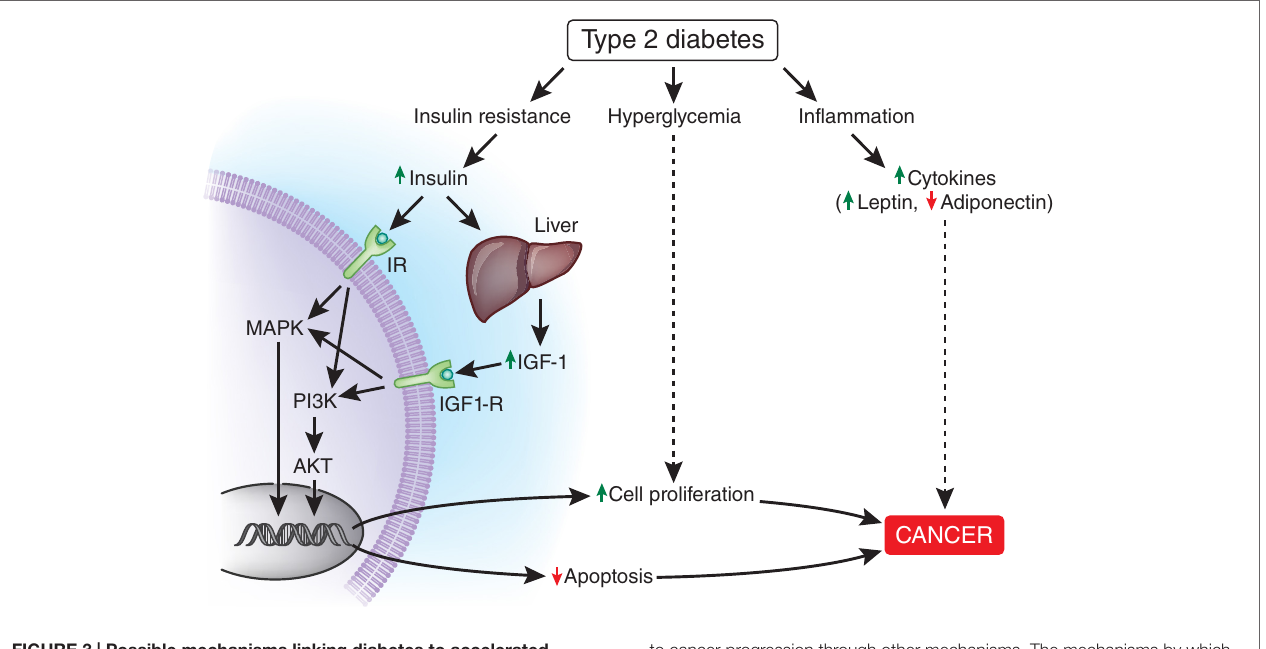
FiGURe 3 | Possible mechanisms linking diabetes to accelerated cancer development . Binding of insulin to the insulin receptor (IR in the figure), likely IR-A and/or binding of IGF-1 to the IGF-1 receptor activate MAPK and PI3K/AKT signaling pathways leading to increased cell proliferation and decreased apoptosis. Hyperglycemia and chronic inflammation also contribute